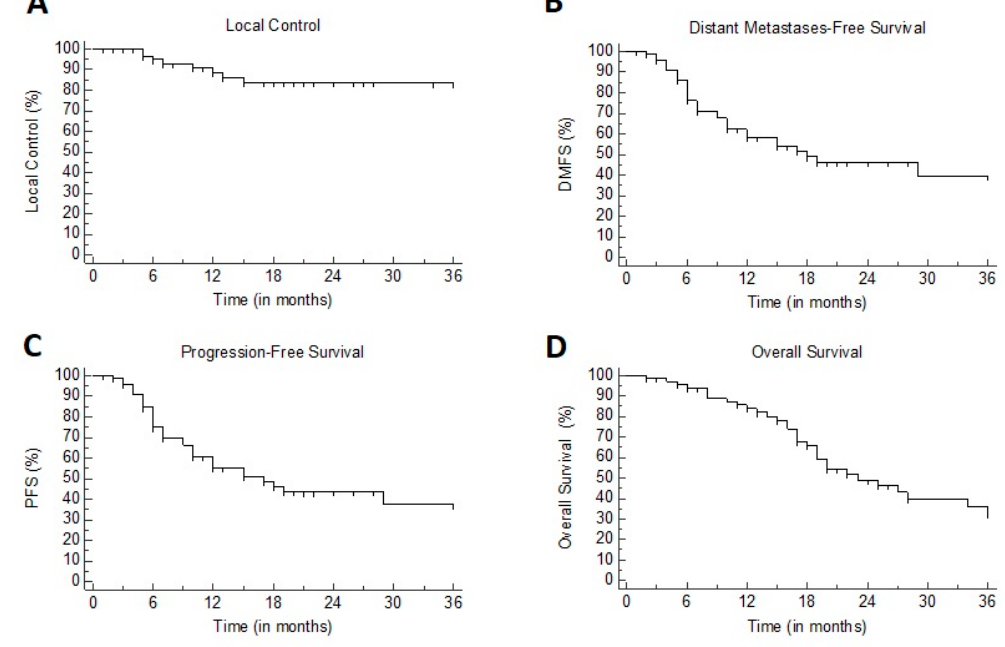
Figure 1. Kaplan–Meier plots for: ( A ) local control (LC). ( B ) distant metastases-free survival (DMFS). ( C ) progression-free survival (PFS). ( D ) overall survival (OS).